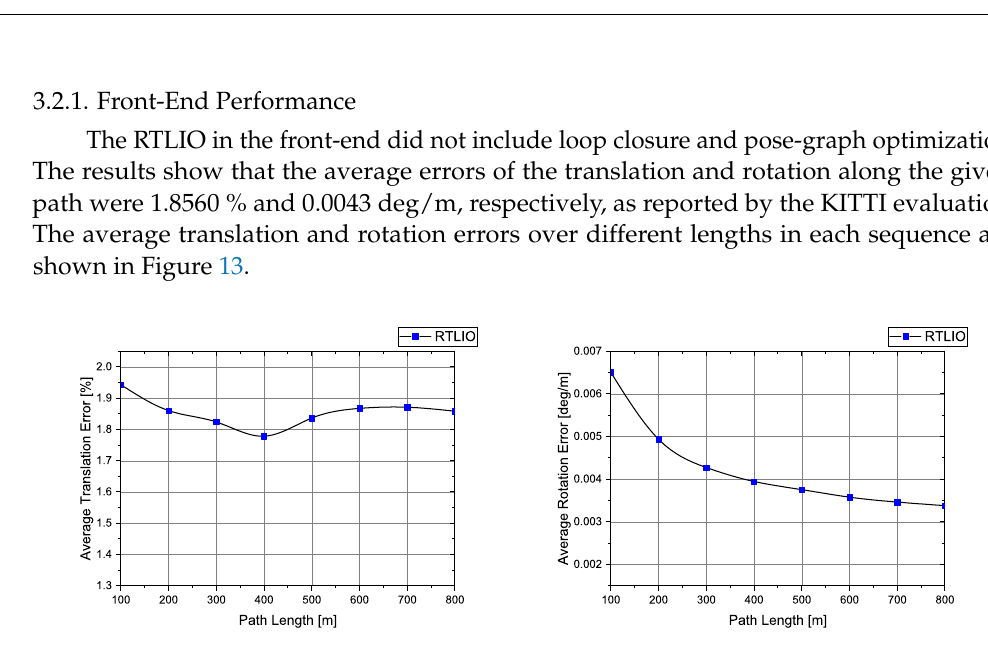
Figure 13. Average translation and rotation errors of the front-end evaluated over different lengths in the KITTI dataset for sequence from 00 to 10.